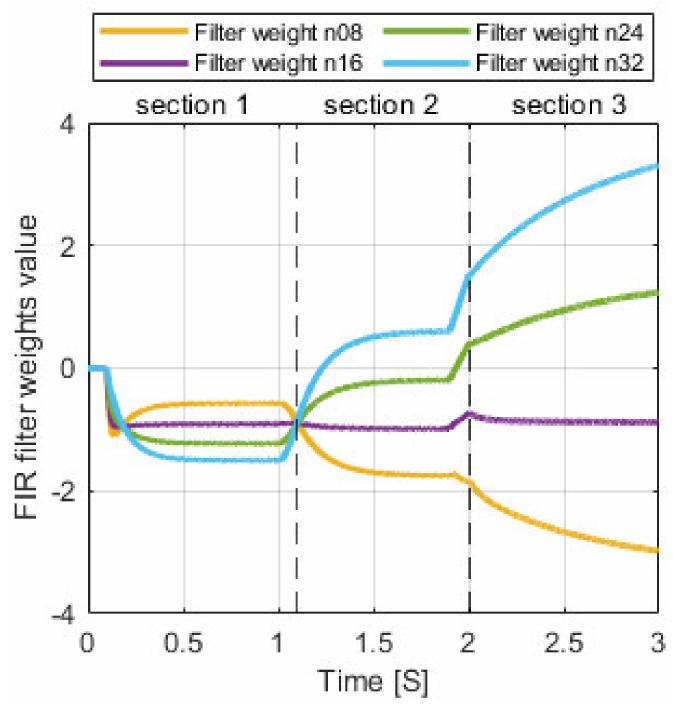
Figure 25. Simulation cycle 1: weight trend in FIR discrete